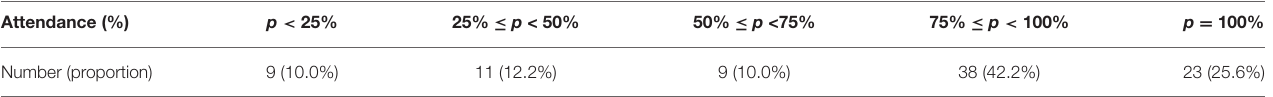
TABLE 6 | Attendance of the intervention group.